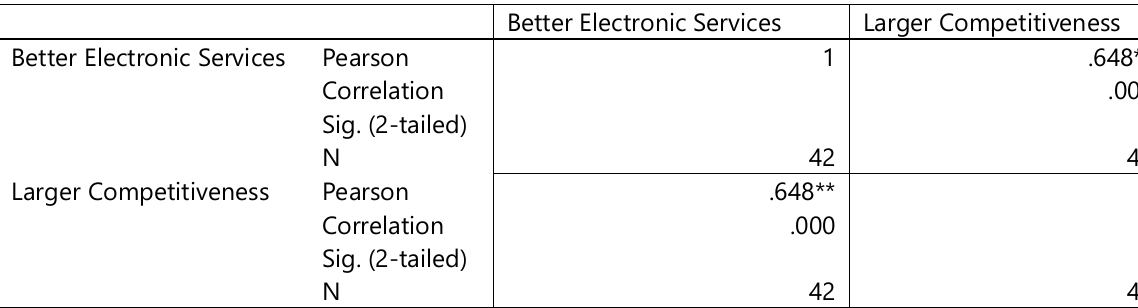
Table 2: Pearson Linear Correlation (Source: Pallant